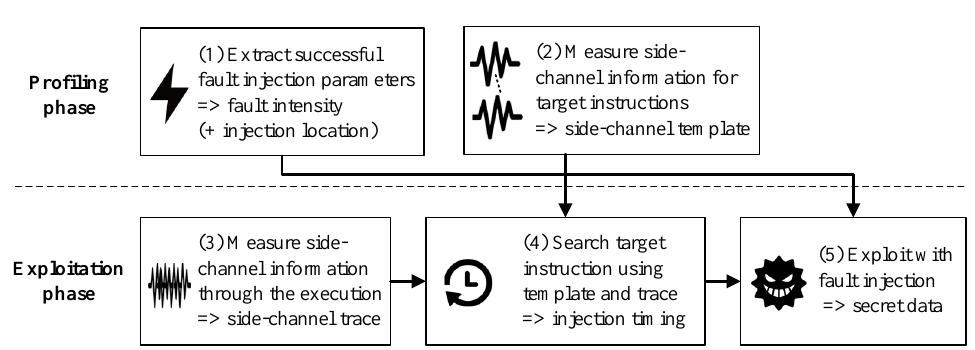
Figure 4: Proposed attack